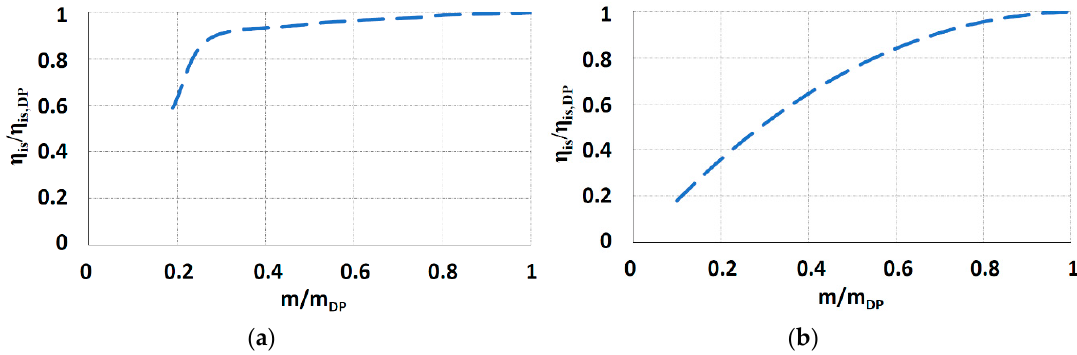
Figure 8. Trend of the isentropic efficiency resized using the design point value against the part-load mass flow rate of ( a ) radial turboexpanders and ( b ) scroll expanders.